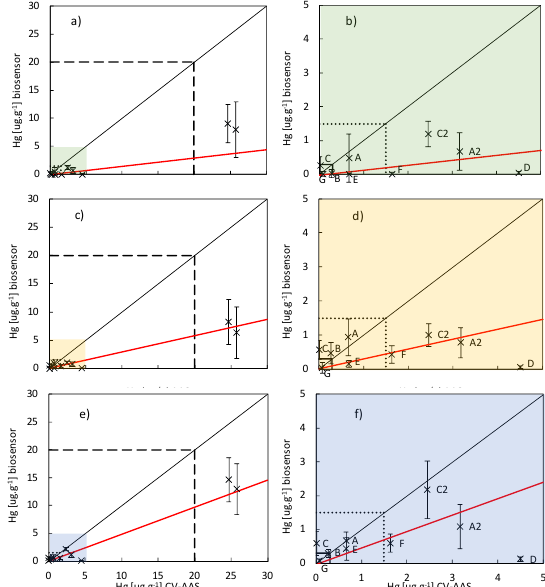
Figure 4. Each plot depicts Hg concentrations in soil samples (A–G, all were used in each plot) estimated by the bioreporter E. coli ARL1 (presumably bioavailable, Y axis) related to the total mercury concentrations assessed by CV AAS (X axis) for three different ways of sample preparations: plots ( a , b )—soil suspensions, plots ( c , d )—water extracts, plots ( e , f )—laccase extracts. The diagonals represent theoretical position of the measured points, when bioavailability would be 100%. Solid line—“preventive value” 0.3 mg/kg, dotted line—“indication value” 1.5 mg/kg, dashed line “indication value” of 20 mg/kg. Presented points are averages from three to five independent repeats of the given pretreatment method and standard addition. Error bars represent sample standard deviations. For details of the regression curves see Table 4.